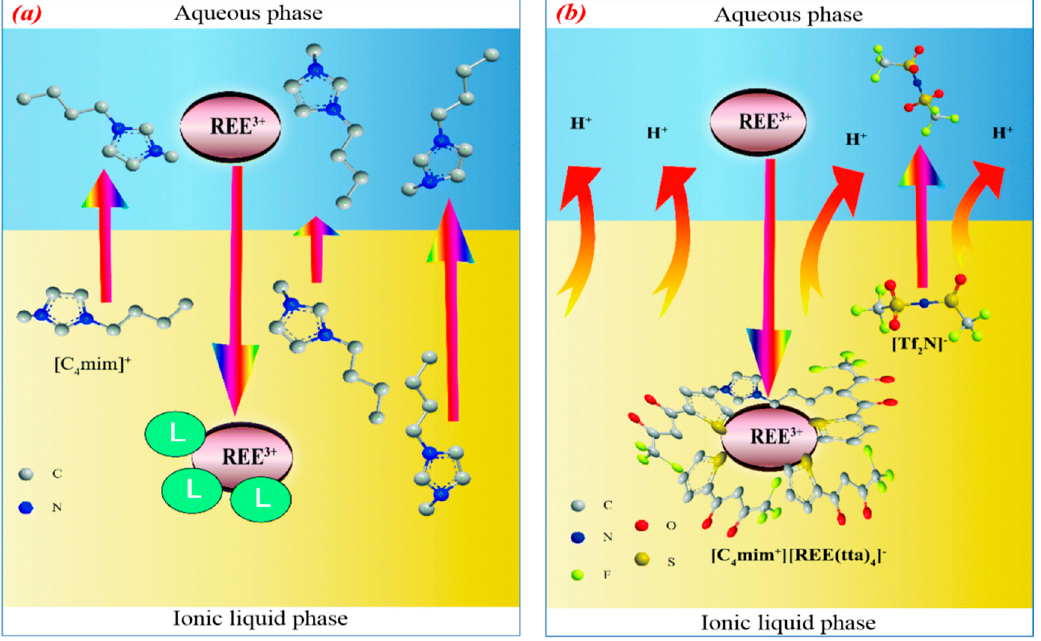
Figure 16. ( a ) Cation exchange in an ionic liquids (IL) system, ( b ) Anion exchange in IL system [143]; published by Royal Society of Chemistry, 2017.